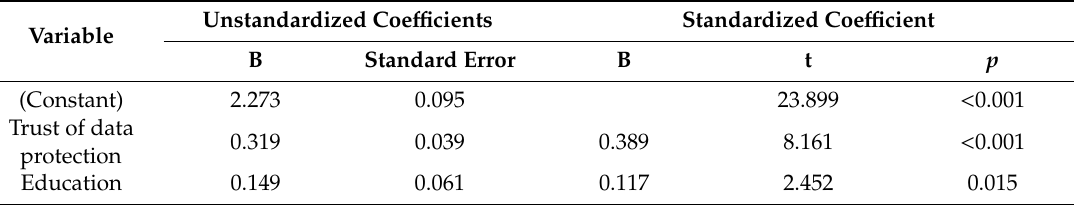
Table 3. Linear regression model: willingness to provide medical information and other variables.